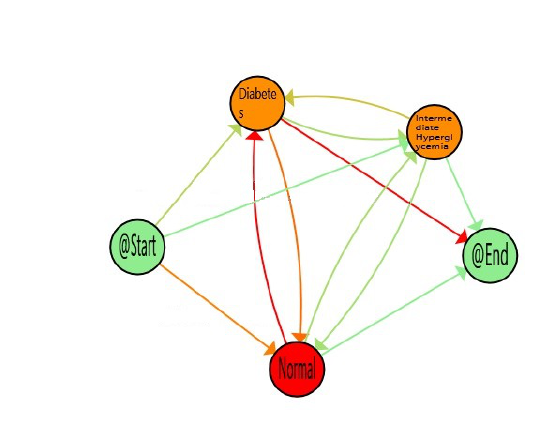
Figure 7. Dynamic FPG for adults (30–65).